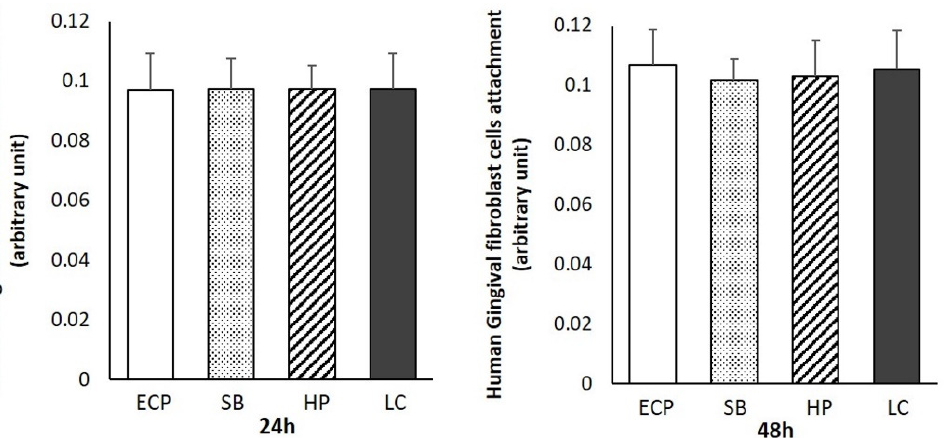
Figure 3. Total numbers of attached human gingival fibroblasts cultured for 24 h and density values after propagation for 48 h on titanium disks. Data are presented as means ± SD ( n = 9).